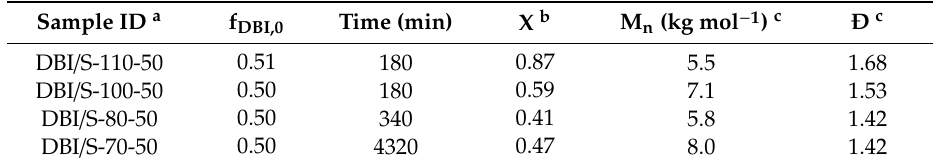
Table 3. Summary of equimolar dibutyl itaconate / styrene copolymerizations in 50 wt% dioxane solution at various temperatures.